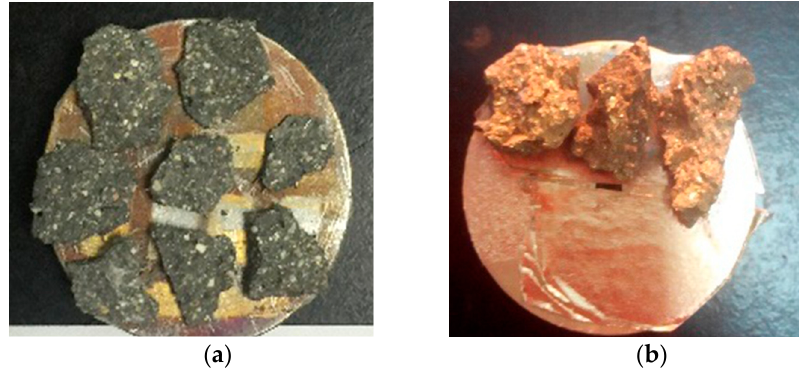
Figure 3. Specimen processing: ( a ) vacuum drying and ( b ) gold spraying.